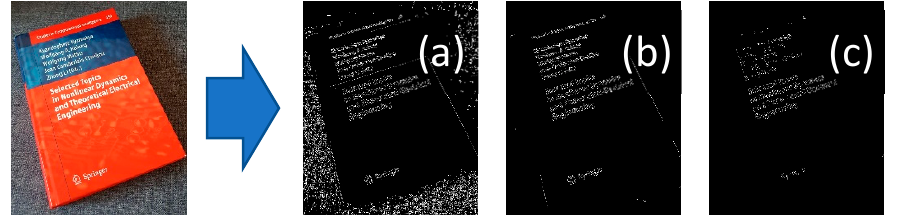
Figure 7. Effect of different blur filters on the image. For a better demonstration, a canny filter is applied on each blurred image to show image differences: ( a ) Blur filter with a kernel size of 3 × 3; ( b ) Blur filter with a kernel size of 5 × 5; and ( c ) blur filter with a kernel size of 7 × 7.